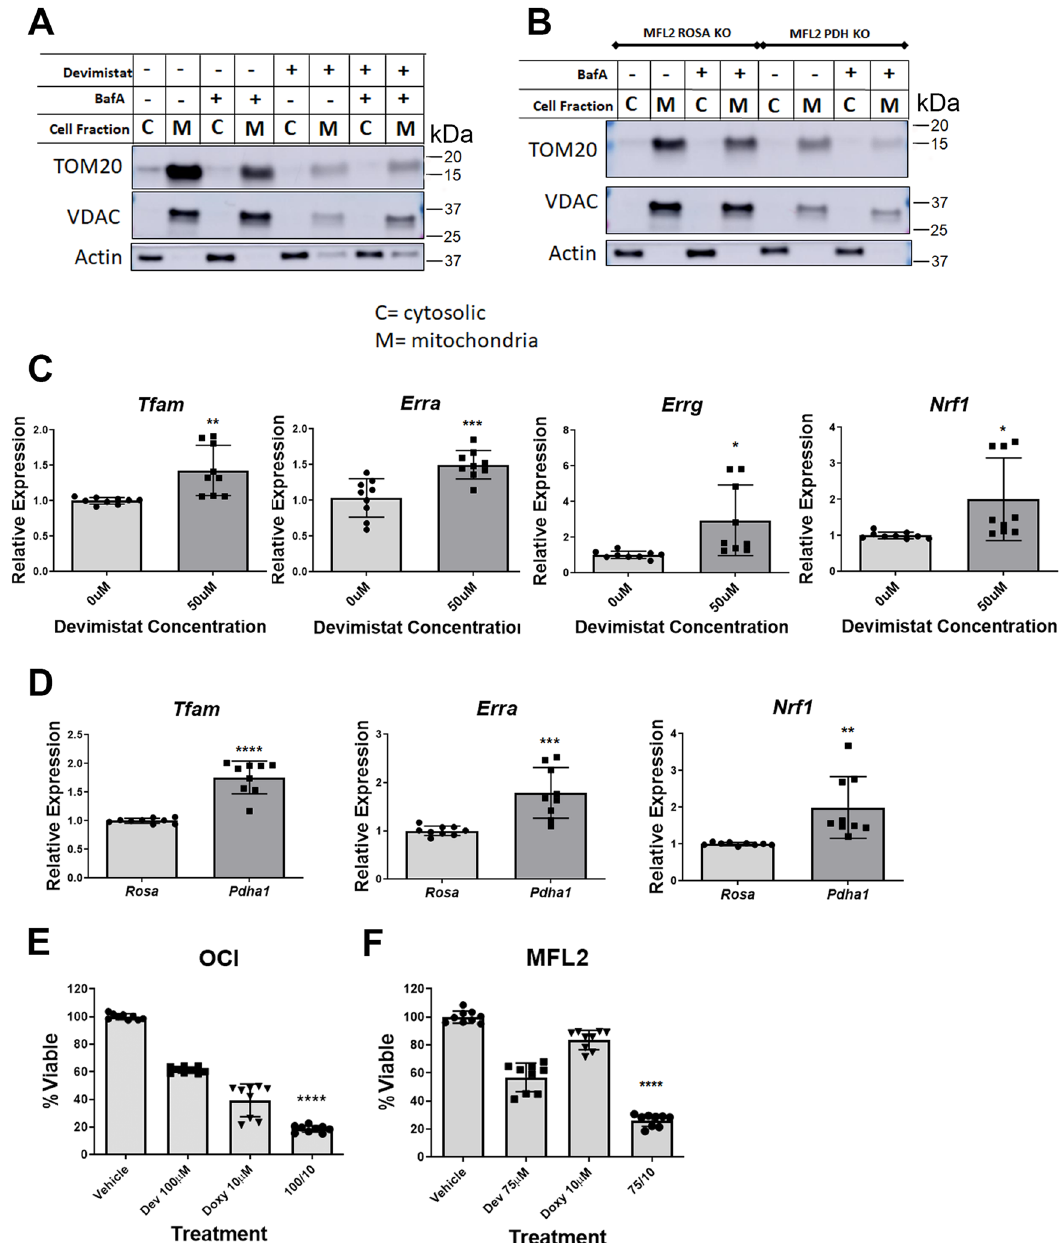
Fig. 4 Devimistat induces mitochondrial turnover. A Western blot for Vdac1 and Tom20. MFL2 cells were treated with 100 µ M devimistat for 24 h, lysed and cytosolic and mitochondrial fractions blotted for the indicated protein. Actin was used as a localization and loading control. Ba fi lomycin A (BafA) is an autophagy inhibitor. B Control compared to Pdha1 -deleted cells. Indicated cells were lysed and separated into cytosolic and mitochondrial fractions and blotted for Vdac1 and Tom20. Actin was used as a localization and loading control. C QPCR of mitochondrial biogenesis genes. MFL2 cells were treated with the indicated amount of devimistat for 24 h and RNA isolated, converted to cDNA and QPCR performed. Shown are the means of three biological replicates each done in triplicate. Means were compared by two-tailed Students t test. D QPCR of mitochondrial biogenesis genes. Pdha1 -deleted and control Rosa26-deleted cells (Rosa) were grown and RNA isolated, converted to cDNA and QPCR performed. Shown are the means of three biological replicates each done in triplicate. Means were compared by two-tailed Students t test. E , F Viability assays of human ( E ) or murine ( F ) AML cells treated with devimistat (dev) or doxycycline (doxy) or both for 72 h Shown are the means of three biological replicates each done in triplicate. Means were compared by one-sided ANOVA with a Tukey ’ s posttest for multiple comparisons **** P value less than 0.0001. *** P value of 0.001 or less. ** P value of 0.01 or less. * P value of 0.05 or less. All error bars represent the standard deviation around the